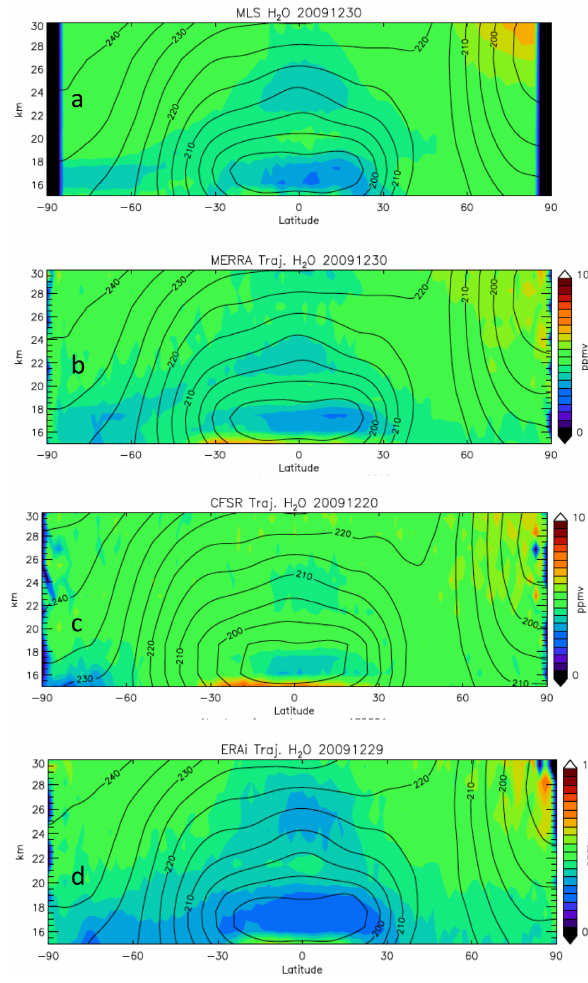
Fig. 4. Water vapor mixing ratio from MLS (a) , MERRA (b) , CFSR Figure 4. Water vapor mixing ratio from MLS (a), MERRA (b), CFSR (c), and ERAi (d). (c) , and ERAi (d) . Black contours show zonal mean Black contours show zonal mean temperature.